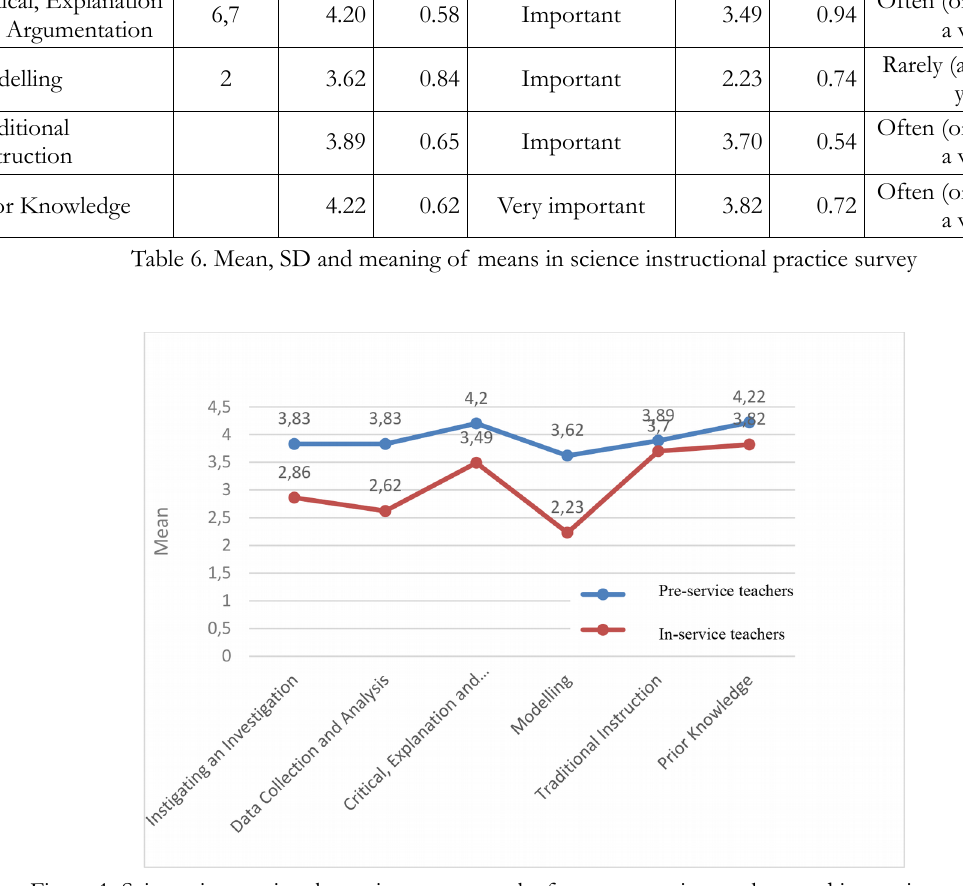
Figure 1. Science instructional practice survey results from pre-service teachers and in-service